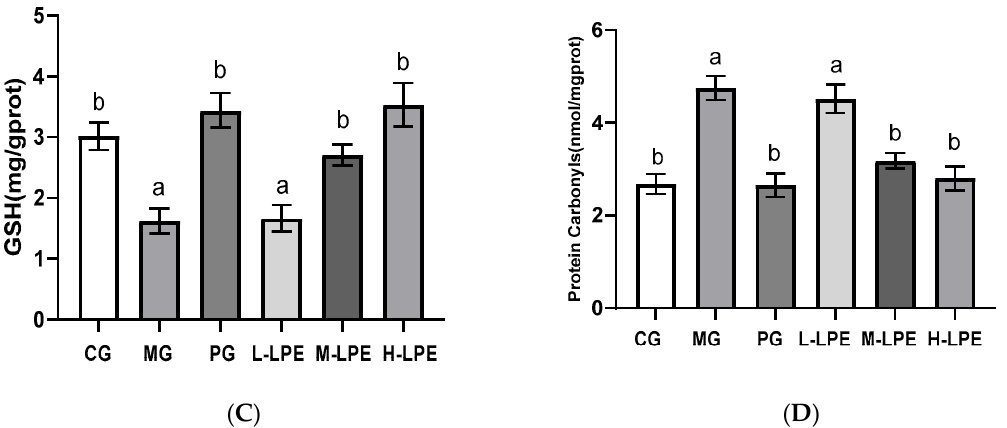
Figure 5. MDA, SOD, GSH, and protein carbonyls levels in the kidney of mice: ( A ) MDA contents in the kidney of mice; ( B ) SOD activity in the kidney of mice; ( C ) GSH contents in the kidney of mice; ( D ) protein carbonyls content in the kidney of mice. Values are expressed as mean ± standard error ( n = 12 in each group). Values with different superscripts showed a difference with statistical significance, p < 0.05, “a” as a statistical difference compared with the blank control group, “b” as a statistical difference compared with the model group.